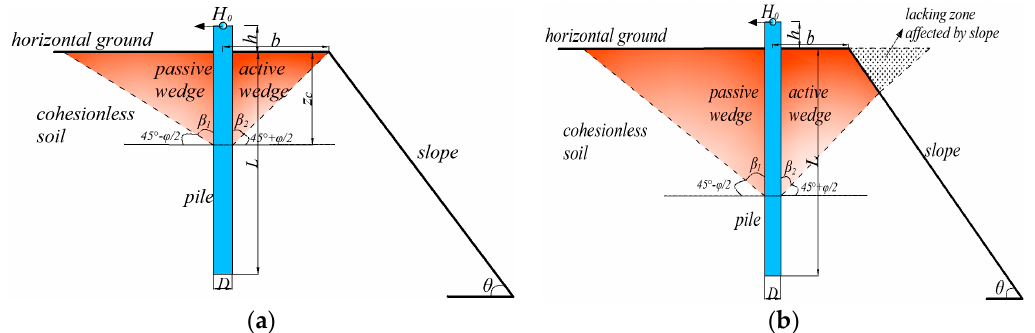
Figure 2. Passive wedge and active wedge formed in front of and behind the pile under lateral load: ( a ) The active wedge does not develop to the slope; ( b ) The active wedge has developed to the slope.